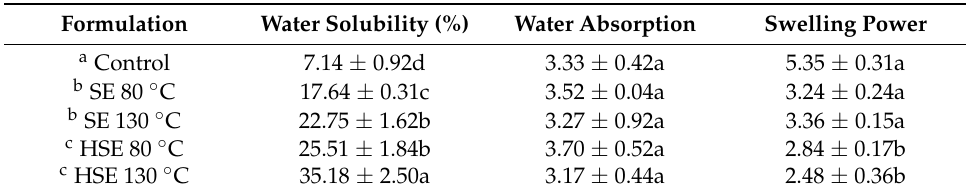
Table 3. Water absorption-related parameters of the soybean-polymer composite.